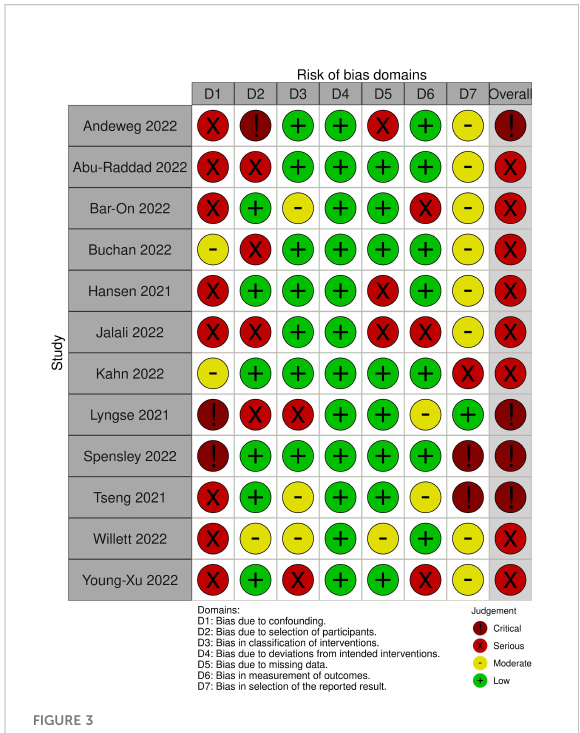
FIGURE 3 Risk of Bias assessments for the outcome "SARS-CoV-2 infection (any type)".